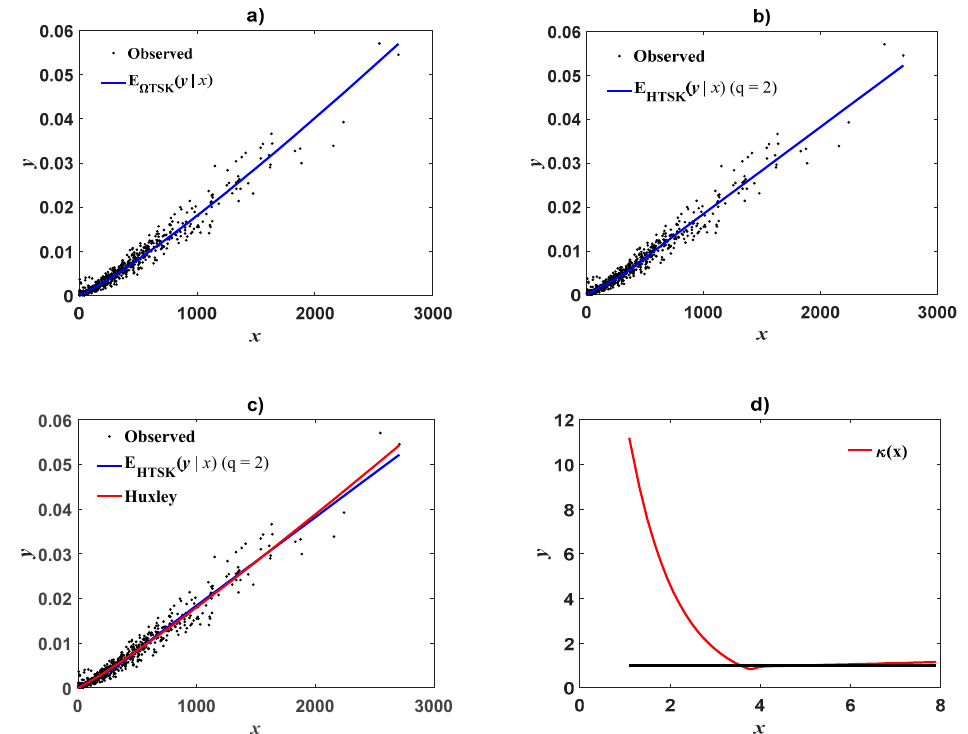
Figure 12. Plots of retransformed Ω TSK ( u ) and direct H TSK ( x ) proxies identified on eelgrass data. Figure 12. Plots of retransformed 𝛺 (cid:3021)(cid:3020)(cid:3012) (𝑢) and direct 𝛨 (cid:3021)(cid:3020)(cid:3012) (𝑥) proxies identified on eelgrass data. (cid:12) (cid:12) Panel ( a ) shows spread about E Ω TSK ( y (cid:12) x ) . Panel ( b ) depicts dispersion about fitted biphasic form Panel ( a ) shows spread about 𝐸 (cid:3078)(cid:3021)(cid:3020)(cid:3012) (𝑦|𝑥) . Panel ( b ) depicts dispersion about fitted biphasic form H TSK ( x ) , ( q = 2 ) . Panel ( c ) compares H TSK ( x ) , ( q = 2 ) , to the power function by Huxley’s model of 𝛨 (cid:3021)(cid:3020)(cid:3012) (𝑥) , (𝑞 = 2) . Panel ( c ) compares 𝛨 (cid:3021)(cid:3020)(cid:3012) (𝑥), (𝑞 = 2) , to the power function by Huxley’s model of simple allometry fitted on direct scales. Panel ( d ) displays the plot of curvature index κ ( x ) . This plot simple allometry fitted on direct scales. Panel ( d ) displays the plot of curvature index 𝜅(𝑥) . This plot exhibits curvature e ff ects more pronounced for the smaller leaves. exhibits curvature effects more pronounced for the smaller leaves. Table 6. Performance metrics for MCA proxies for observed eelgrass leaf biomass. We include retransformed forms of λ m ( u ) : ( m = 0, 1, 2) and , Ω BL ( u ) : (biphasic) π m ( u ) : ( m = 3, 5), Ω ML ( u ) (biphasic) and Ω TSK ( u ) ( q = 2, 5) compared to Huxley’s formula of simple allometry and directly fitted H TSK ( x ) : ( q = 2, q = 3 ) . AIC stands for Akaike’s information criterion, ρ symbolizes Lin’s concordance correlation coe ffi cient, R 2 denotes determination coe ffi cient, SEE standard error of estimation and MPE mean prediction error.